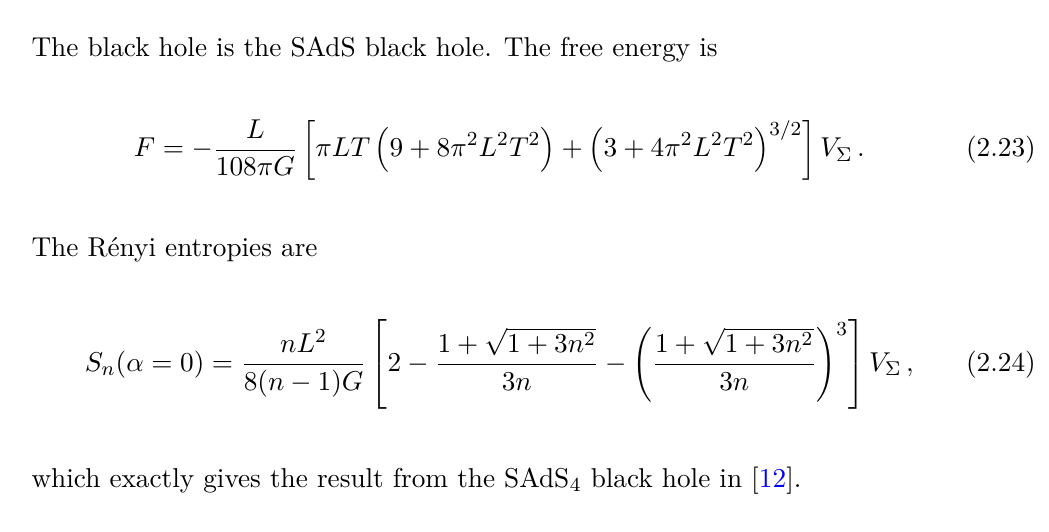
√ √ 3 or 3 . A third-order phase transition occurs √ √ 3 < α < 3 , a 1 m >